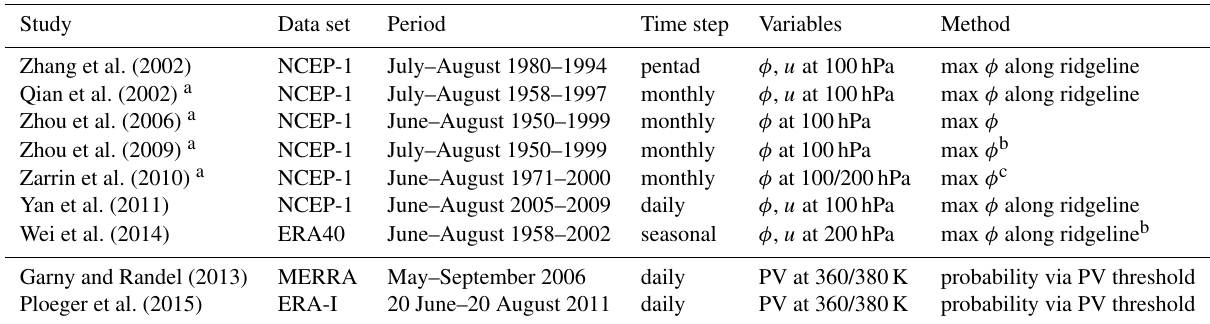
Table 2. Overview of studies addressing bimodality. Geopotential height and zonal wind are denoted by φ and u respectively. For details see Sect.